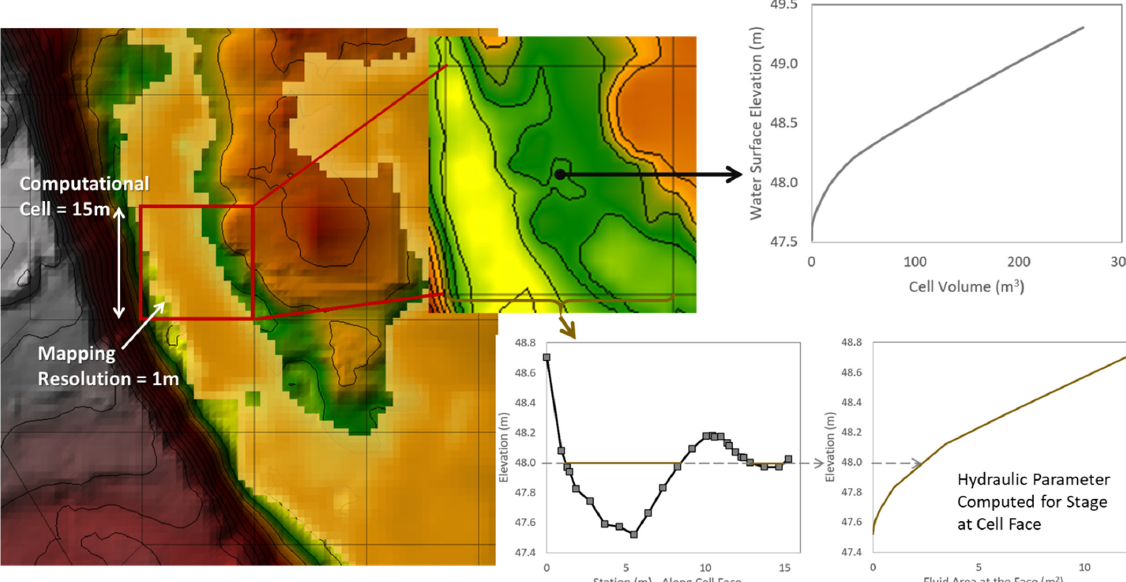
Figure 9. Illustration of the sub ‐ grid approach in HEC ‐ RAS. Intra ‐ cell stage ‐ volume curves and hydraulic parameter curves at each cell face incorporate terrain information at the resolution of the terrain, allowing larger cells and shorter run times. Sub ‐ grid mapping also computes inundation area within each cell.